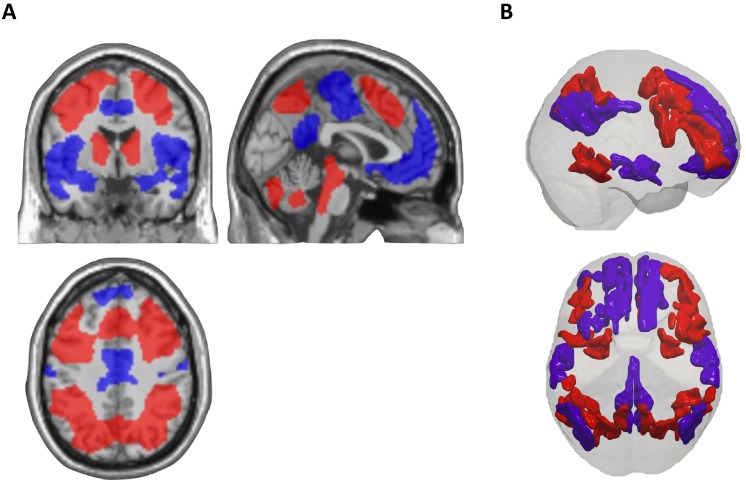
Task-related neural activation and task-related cortical networks.(A) Significant task-induced activations (red) and deactivations (blue) that correlate with increasing working memory load, showing increased activation within dorsolateral prefrontal cortex and parietal cortex, and decreased activation within ventromedial prefrontal cortex, posterior cingulate cortex and medial temporal lobe. Activation and deactivation maps thresholded at whole-brain cluster threshold (cluster-level family-wise error corrected P < 0.05), and displayed in coronal, sagittal and axial sections overlaid on a single-subject normalized T1 image in MNI space (see Table 1 for statistical results). (B) Lateral (top) and top-down (bottom) rendering illustrating nodes of the empirical task-positive (TPN, in red) and default mode (DMN, in blue) networks identified by the community detection algorithm.